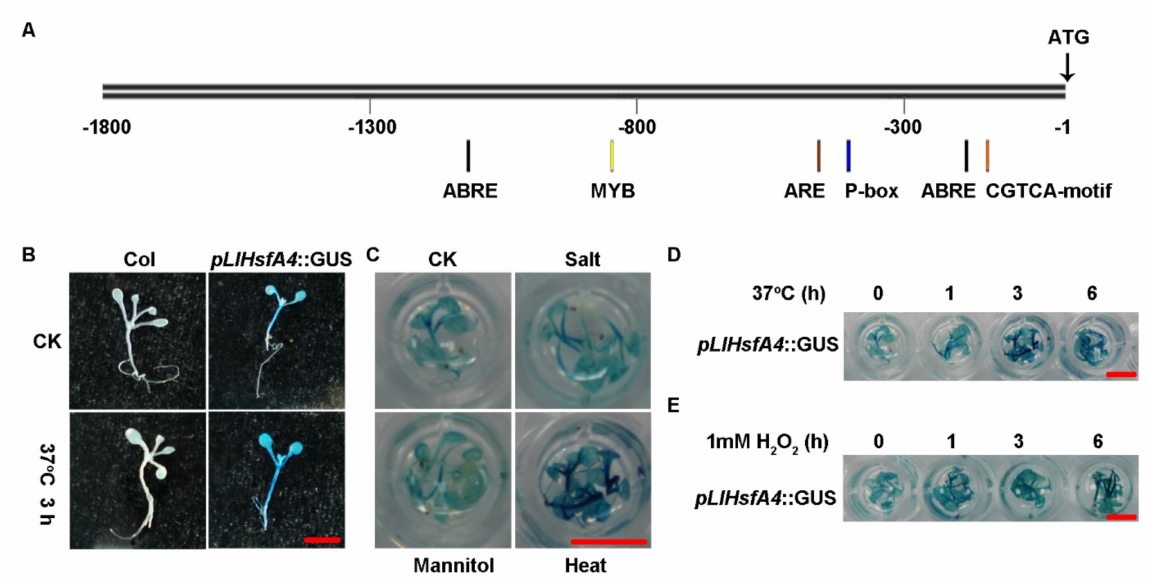
Figure 3. Expression analysis of HsfA4 using pLlHsfA4 ::GUS transgenic Arabidopsis . ( A ) Cis-element analysis of LlHsfA4 promoter using PLACE data. GUS staining of pLlHsfA4::GUS transgenic Arabidopsis seedlings were treated with different abiotic stresses: heat stress in ( B – D ), salt(150 mM NaCl) and osmosis (300 mM Mannitol) in ( C ) and ROS(1mM H 2 O 2 ) in ( E ). Bar: 50